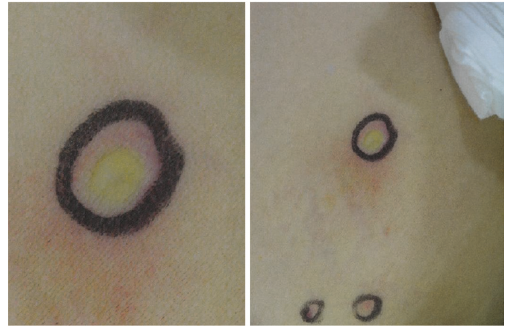
Figure 3: Erythema and blister formation on the